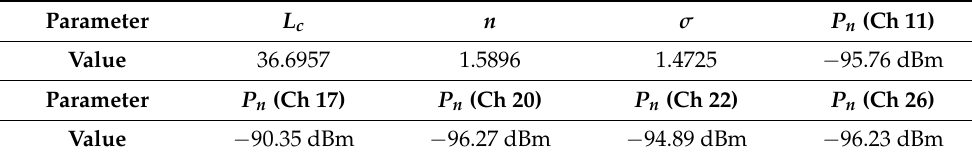
Table 1. Main parameters required for the spatial distribution model of PRR.